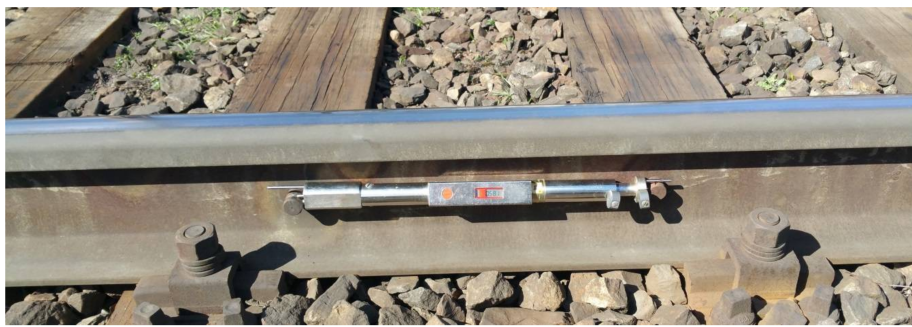
Figure 7. MS-02 Longitudinal force gauge (source: photo made by Jacek Makowski). Figure 8 shows the components of the MS-02 longitudinal force